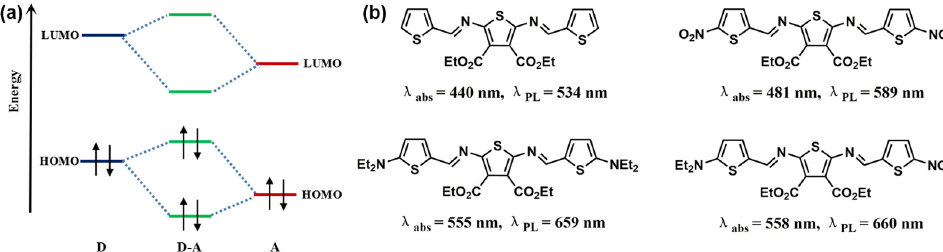
Figure 4. ( a ) Interaction of energy levels of a donor (D) and acceptor (A) leading to a narrower HLG; ( b ) Chemical structures of push-push (D-D), pull-pull (A-A) and push-pull (D-A) azomethines.